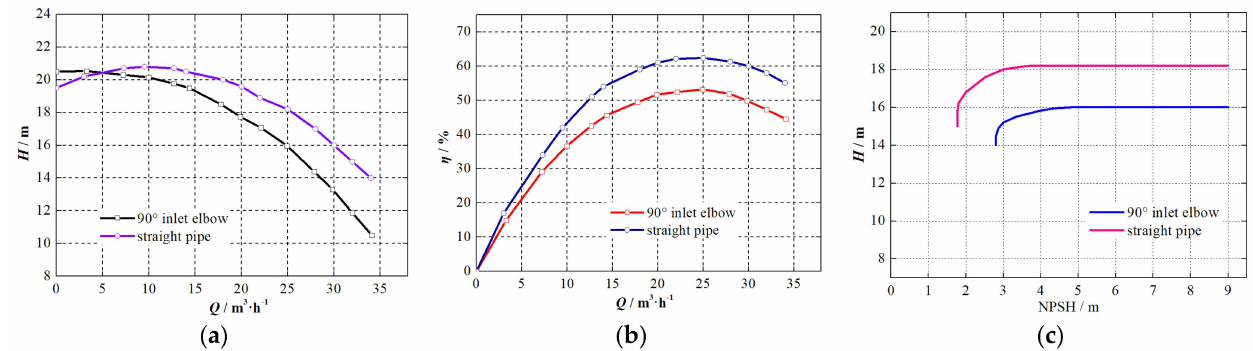
Figure 4. Comparison performance characteristics of model pumps with elbow inlet and straight pipe. ( a ) H - Q curve. ( b ) η - Q curve. ( c ) cavitation curve.